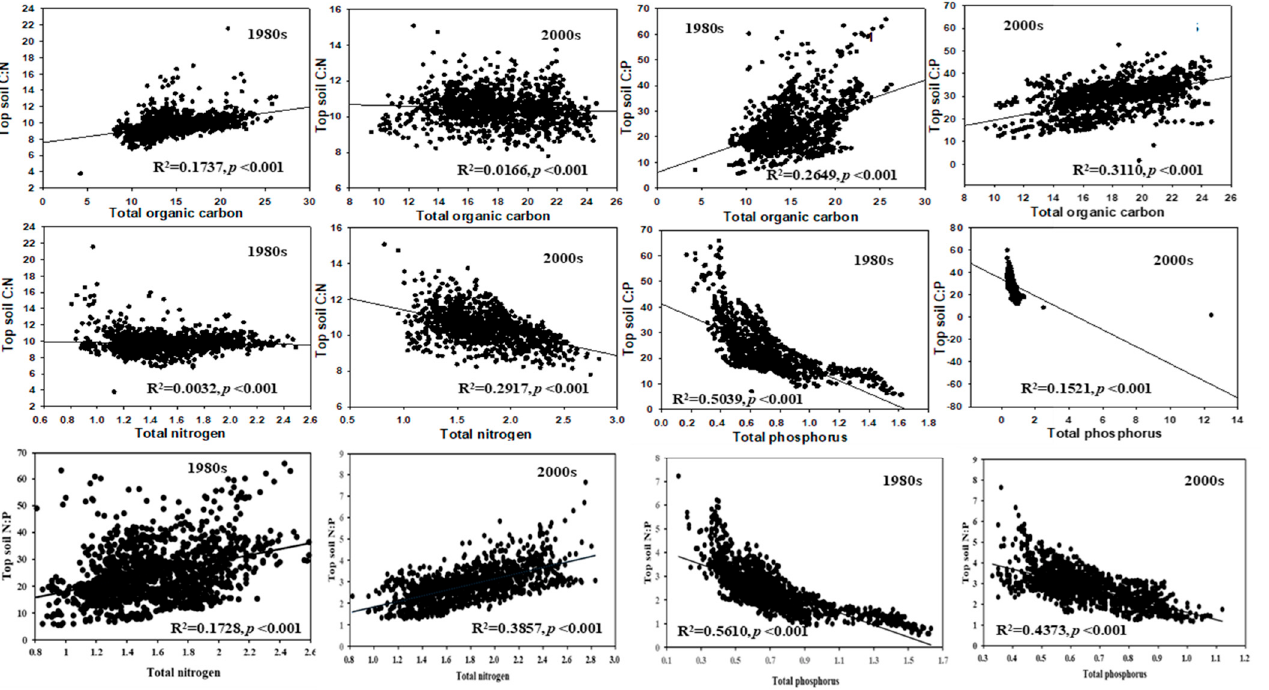
Figure 4. Correlations between topsoil C:N, C:P, or N:P and corresponding C, N, or P